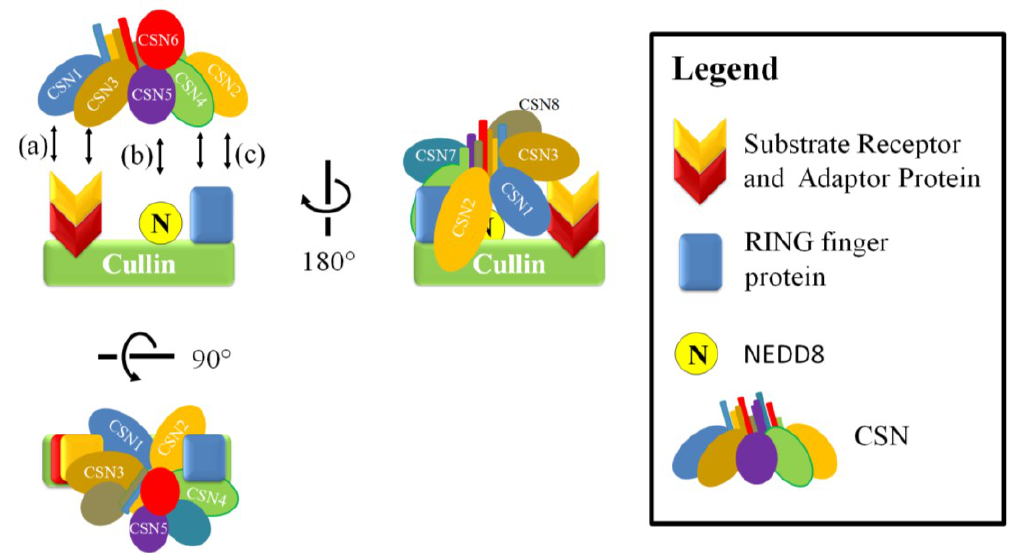
Figure 5. The CSN and CRL interaction. The CSN-CRL association involves the interaction of CSN1 and CSN3 on the substrate receptor (a) and CSN2 and CSN4 on the RING finger protein and the C-terminal portion of the cullin (c) [34,89]. These interactions position and activate CSN5 to allow deneddylation to occur